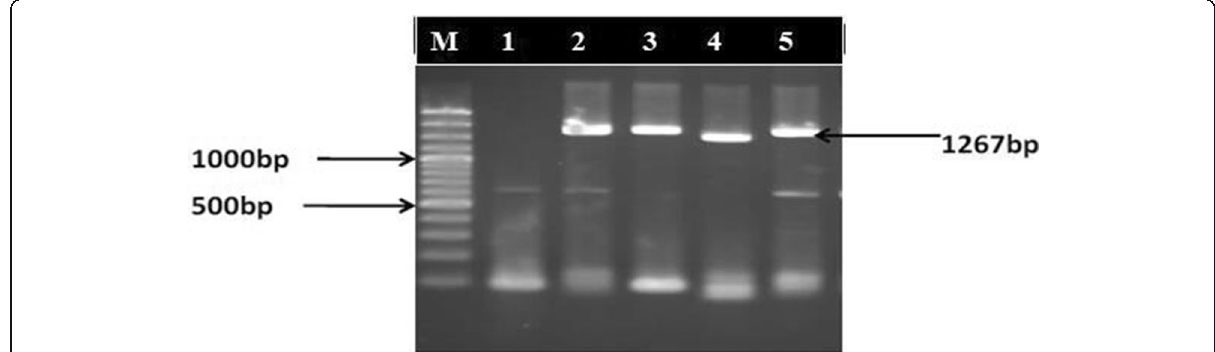
Fig. 1 Amplicons of the 16Sr RNA gene of representative S. aureus with a size of 1267 bp. Lane M is a 100-bp plus DNA marker (DNA ladder, BioBasic); lanes 1 to 5 are test